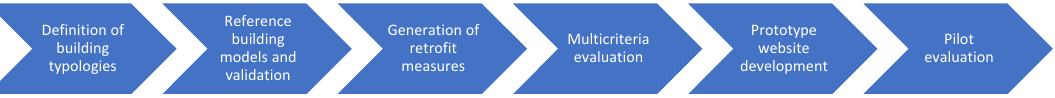
Figure 1. The methodology used to create the online tool.